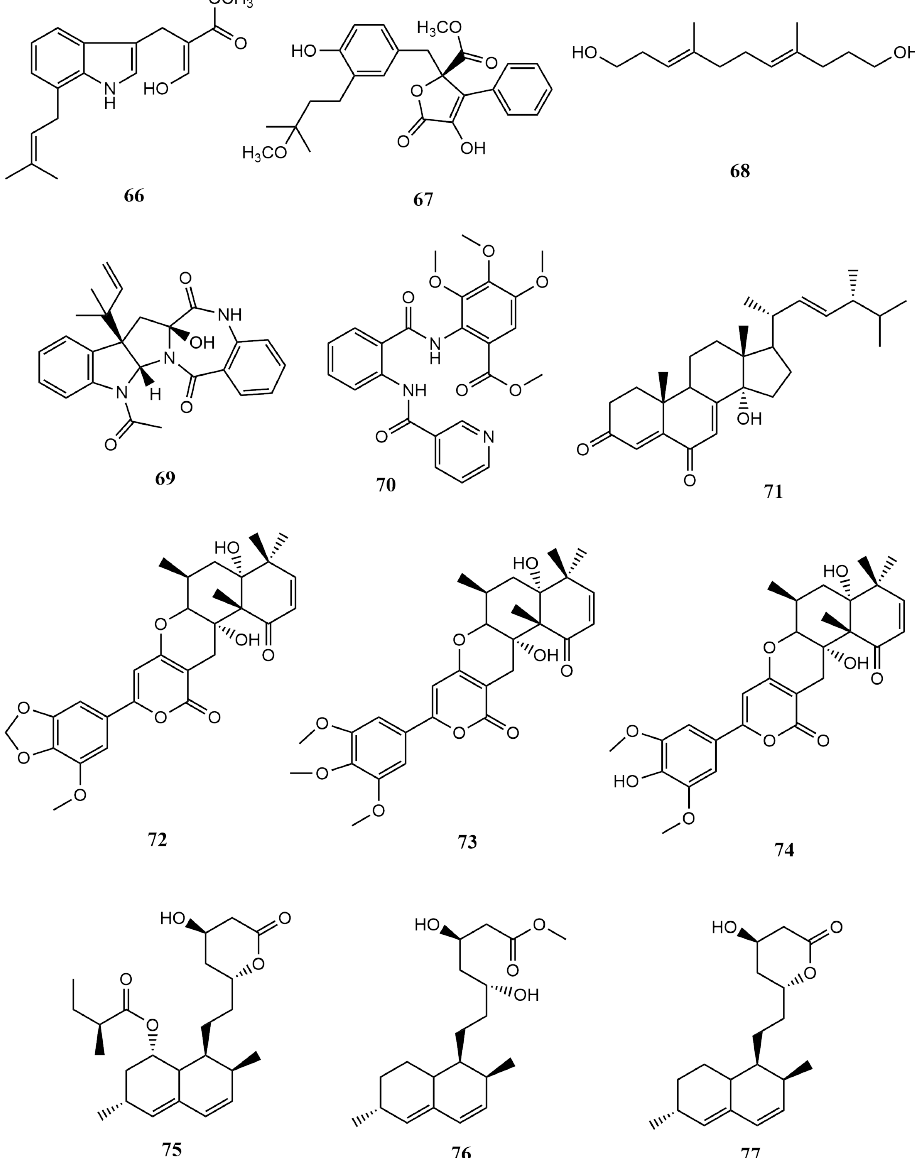
Figure 8. Additional metabolites ( 66 – 77 ) from the soft-coral Sarcophyton -derived marine fungi. In 2018, a total of 11 acyclic merohemiterpenes were isolated from the Sarcophyton subviride -derived fungus Penicillium bialowiezense in the South China Sea [53]. The potato dextrose agar (PDA) cultured fungus yielded the compounds 8-O-methyl mycophenolic acid ( 78 ), 3-hydroxy mycophenolic acid ( 79 ), 6-(5-carboxy-3-methylpent-2-enyl)-7-hydroxy- 3,5-dimethoxy-4-methylphthalan-1-one ( 80 ), 6-(5-methoxycarbonyl-3-methylpent-2-enyl)-3,7- dihydroxy-5-methoxy-4-methylphthalan-1-one ( 81 ), 6-(3-carboxybutyl)-7-hydroxy-5-methoxy- 4 -methylphthalan-1-one ( 82 ), 6-[5-(2,3-dihydroxy-1-carboxyglyceride)-3-methylpent-2-enyl]- 7-hydroxy-5-methoxy-4 -methylphthalan-1-one ( 83 ), 6-[5-(1-carboxy-4- N